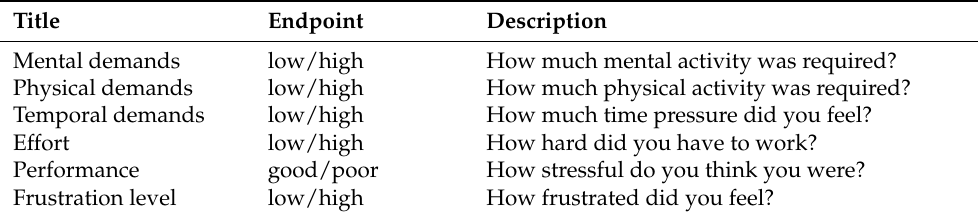
Table 1. NASA-TLX mental workload self-rating questionnaire